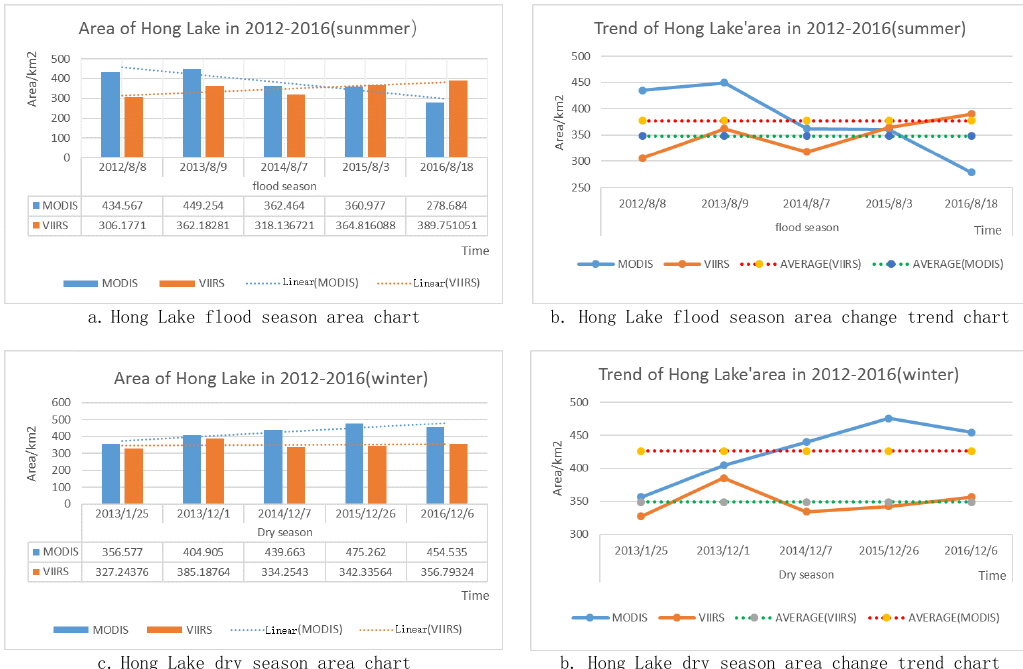
Figure4: Hong Lake’ area statistics and trends in 2012~2016(including VIIRS and MODIS), where a and c in the linear use of Office excel software generated linear trend analysis of the